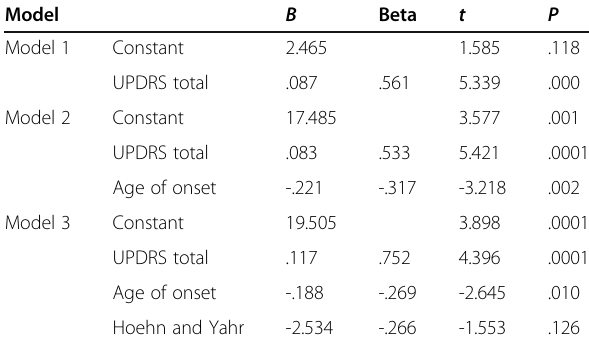
Table 6 Hierarchical multivariable regression analysis for